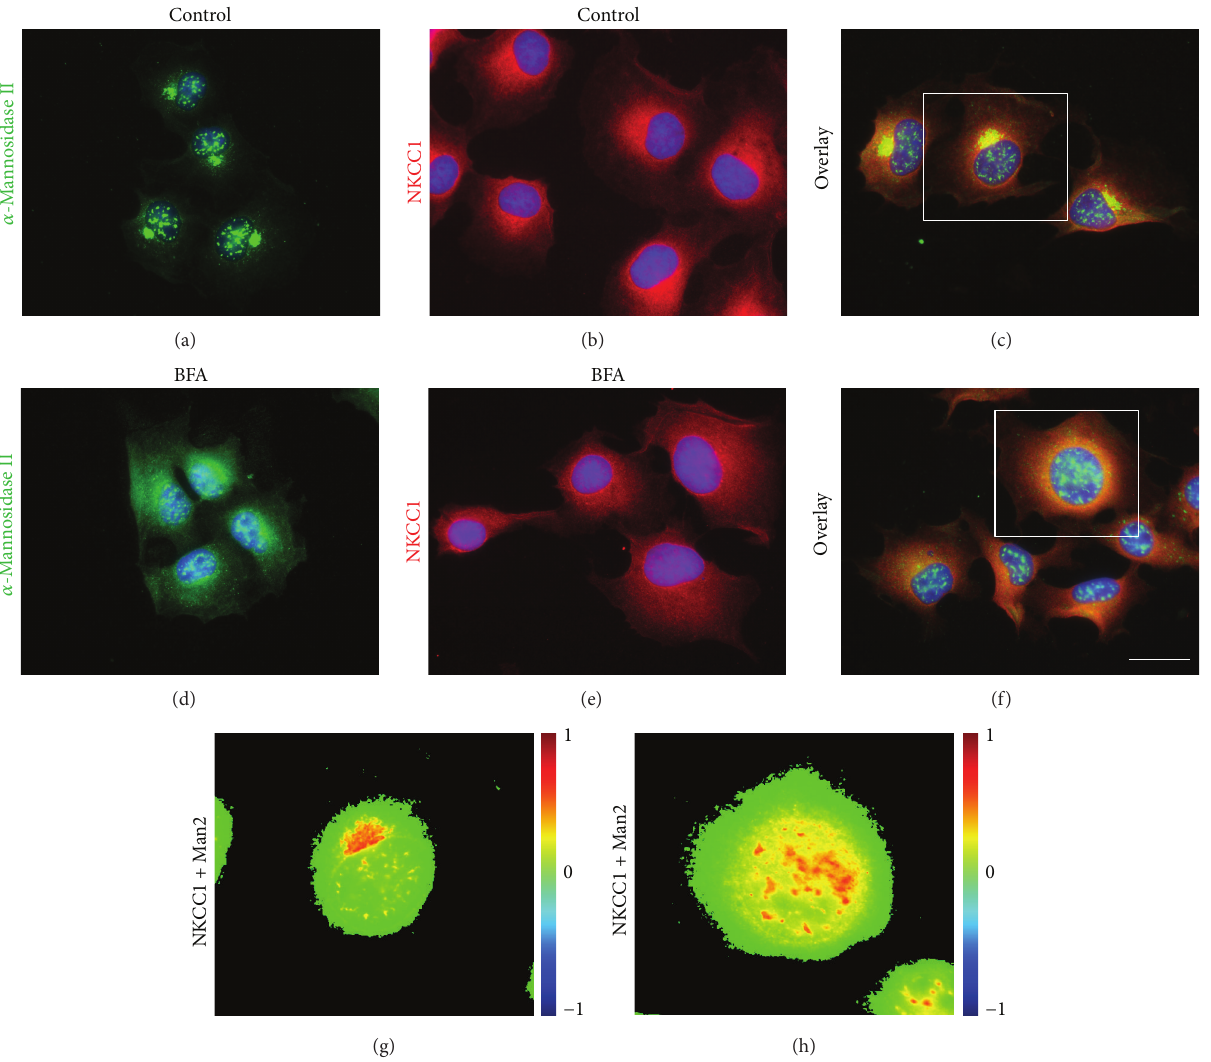
Figure 7: NKCC1 localizes in cis /medial-Golgi cisternae. ((a)–(c)) Shown are representative images of COS7 cells grown under control conditions or treated for 16 h with 1 𝜇 g/mL of brefeldin A (BFA, (d)–(f)). Immunoreactive 𝛼 -mannosidase II (Man2, (a) and (d)) and NKCC1 ((b) and (e)) were detected by using primary antibodies directed against these proteins and developed using secondary antibodies labeled with FITC (green) and Cy3 (red), respectively. ((c) and (f)) Shown are superimposed images to obtain an overlay representing colocalization of NKCC1 and Man2. The scale bar represents 10 𝜇 m. ((g)-(h)) Heat-maps of the squared cells in (c) and (f), respectively, computed by using NIH ImageJ